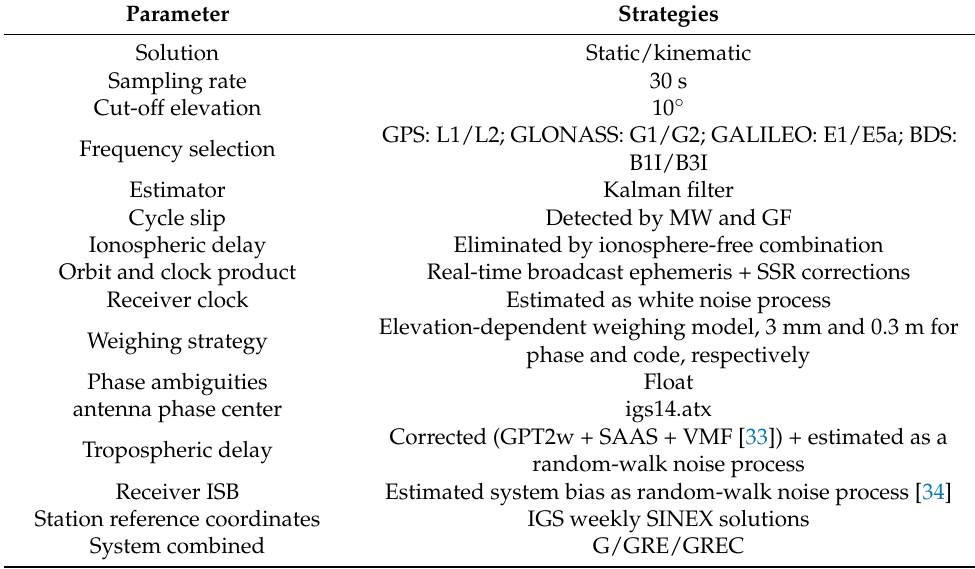
Table 2. The positioning strategies of PPP.